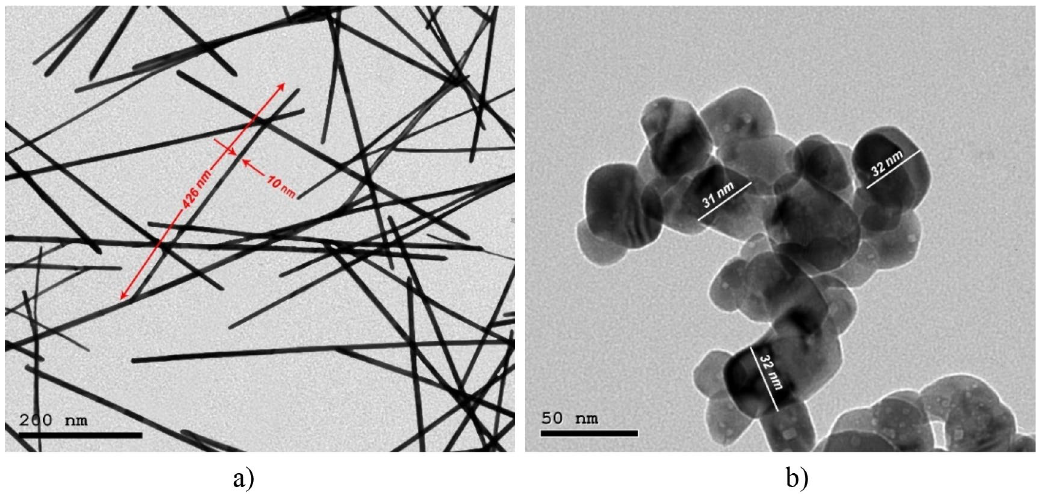
Figure 2. HR-TEM of CuO-NWs ( a ) and CuO-NPs ( b